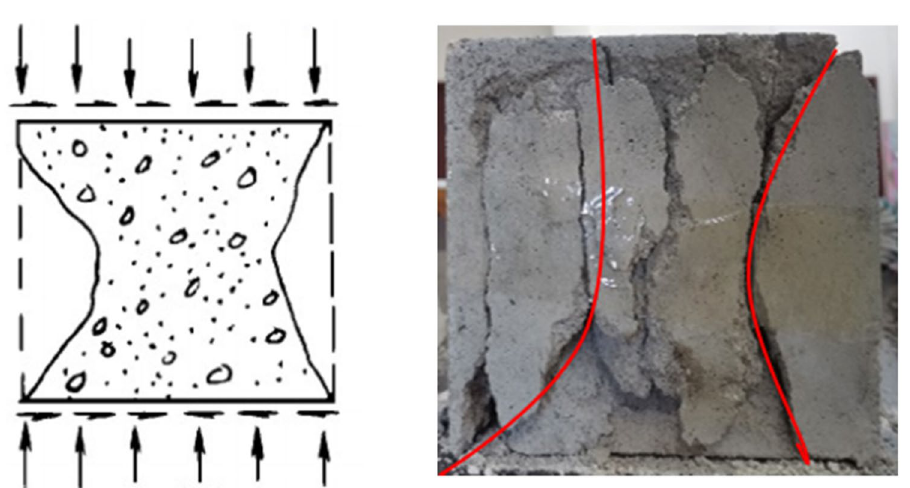
Figure 10. Destruction image of the intact